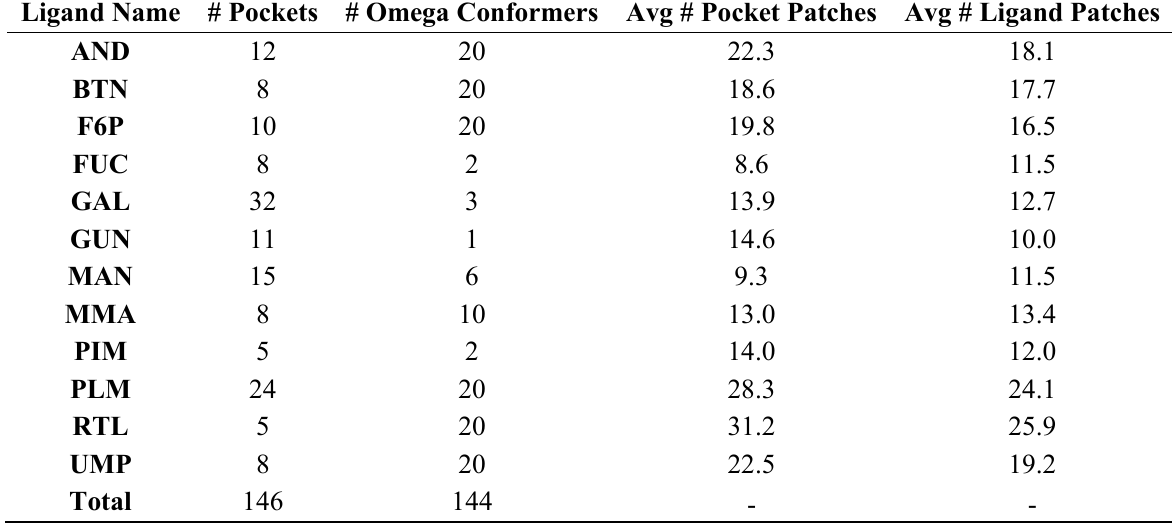
Table 1. Huang data